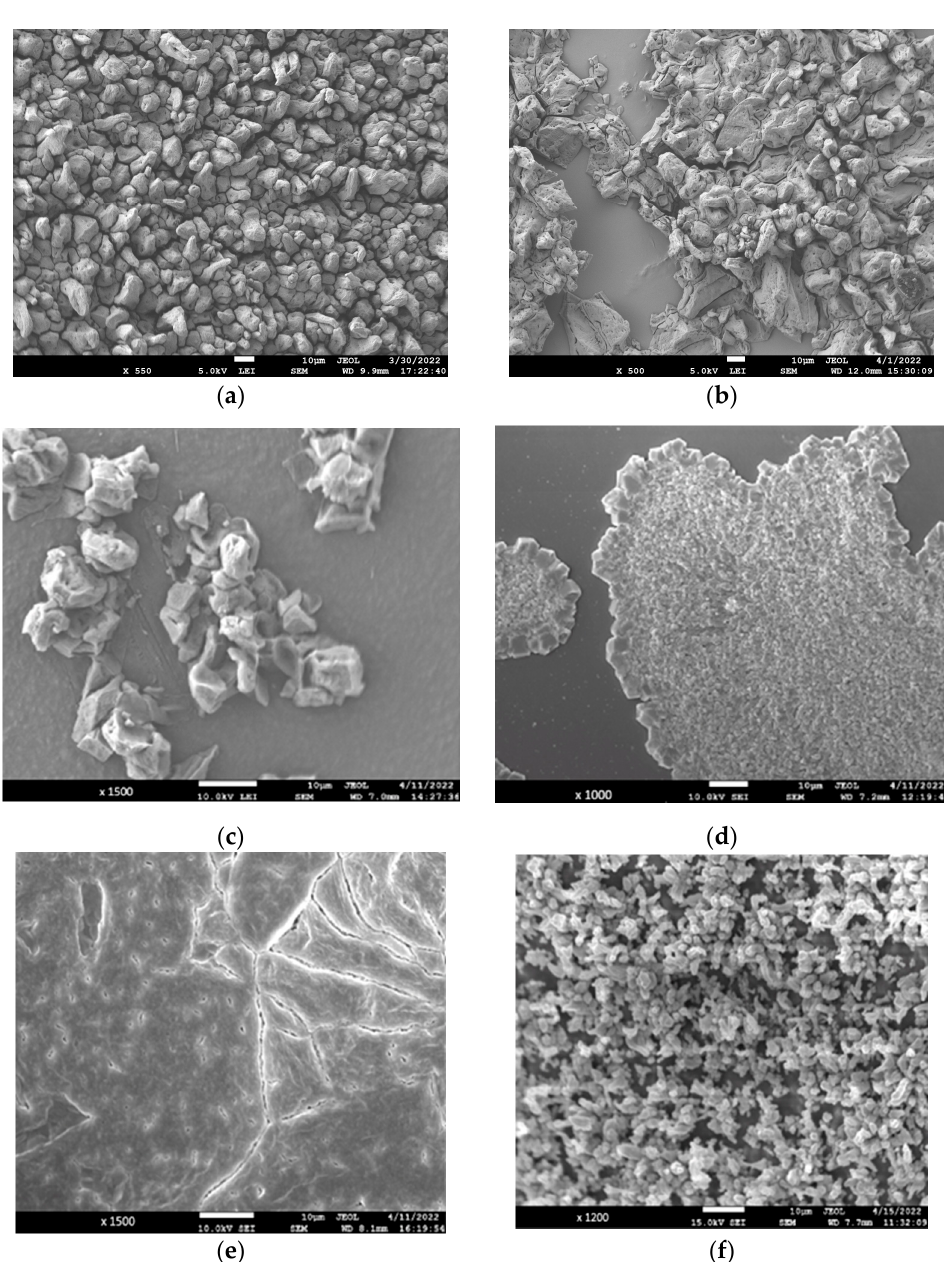
Figure 7. SEM micrographs of the surfaces of films based on CS ( a ), FA-CS derivative ( b ), CS–GEL ( c ), CS–GEL-FA derivative ( d ), CMC ( e ) and CMC-FA-derivative ( f )